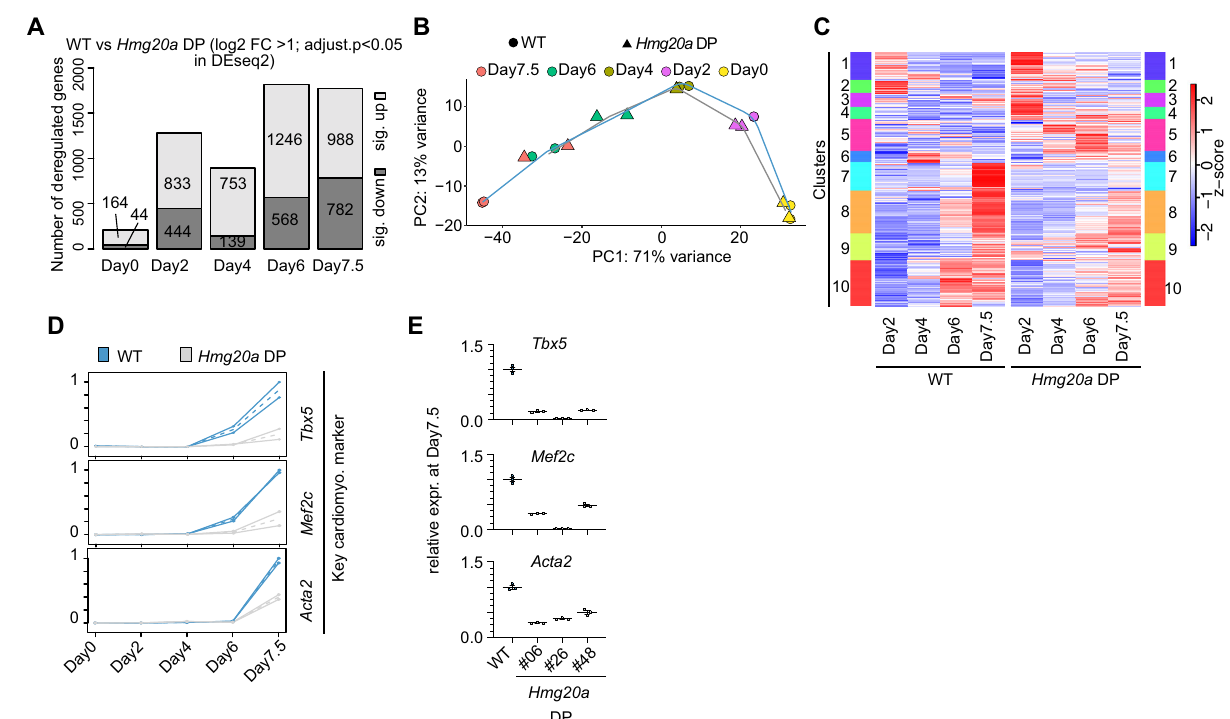
Fig. 6 | HMG20A regulates cardiomyocyte transcription programs. A Stacked Bar plot of numbers of signi fi cantly up (log2 fold change >1) and down (log2 fold change< − 1)regulatedgenes(adjusted p -value<0.05)duringindicatedtimepoints of cardiomyocyte differentiation of WT and Hmg20a DP clone #26 mESCs as identi fi ed by mRNA-seq. B Principle component Analysis (PCA) of RNA-seq data of two replicates of WT (circle) and Hmg20a DP clone#26 (triangle) atDay0 (yellow), Day2 (magenta), Day4 (olive), Day6 (green) and Day7.5 (red) differentiation time points(seeFig.5Fforcardiomyocytedifferentiationscheme). C Heatmapshowing thez-scaledexpressionvaluesfromallsigni fi cantderegulatedgenescomparingthe differentiationsteps(Day2vs.4;4vs.6;6vs.7.5).Genesareclusteredaccordingto